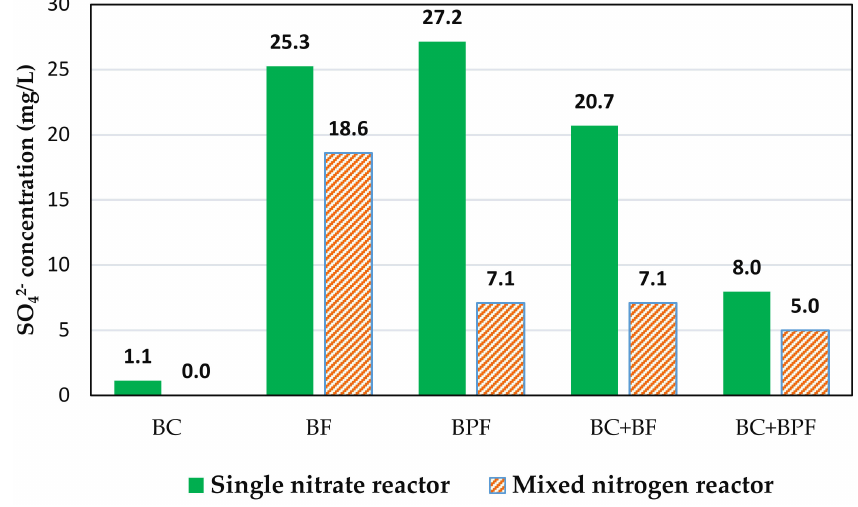
Figure 3. The amount of produced SO 42 − concentrations after 5 days of incubation compared with single nitrate reactors (greenish filled) and mixed nitrogen reactors (reddish diagonal